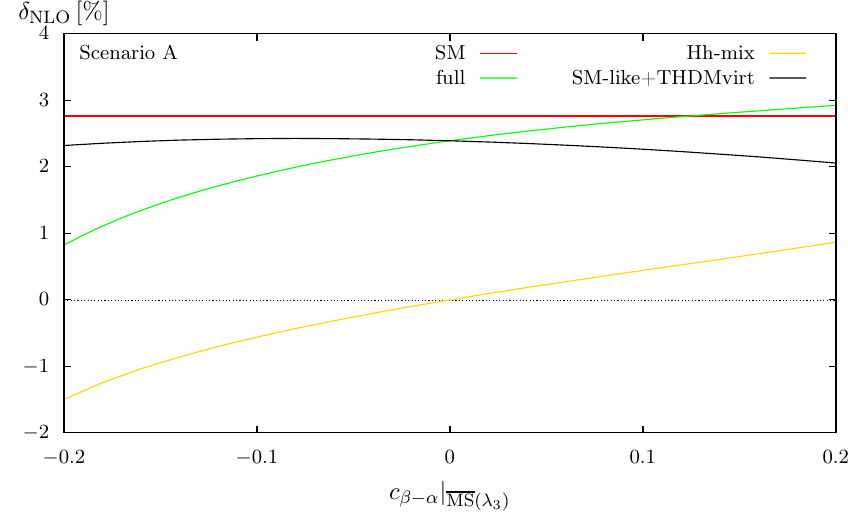
Figure 16 . The full relative NLO corrections to h 4 f (green) split into di(cid:11)erent subcontributions. ! The SM-like contribution consists of all diagrams that have a SM equivalent, the THDM-virt contribution includes all one-loop and counterterm contributions that involve heavy Higgs bosons (sum of the two parts shown in black), and Hh-mixing contribution is displayed in yellow. For comparison, the relative NLO corrections in the SM are shown in